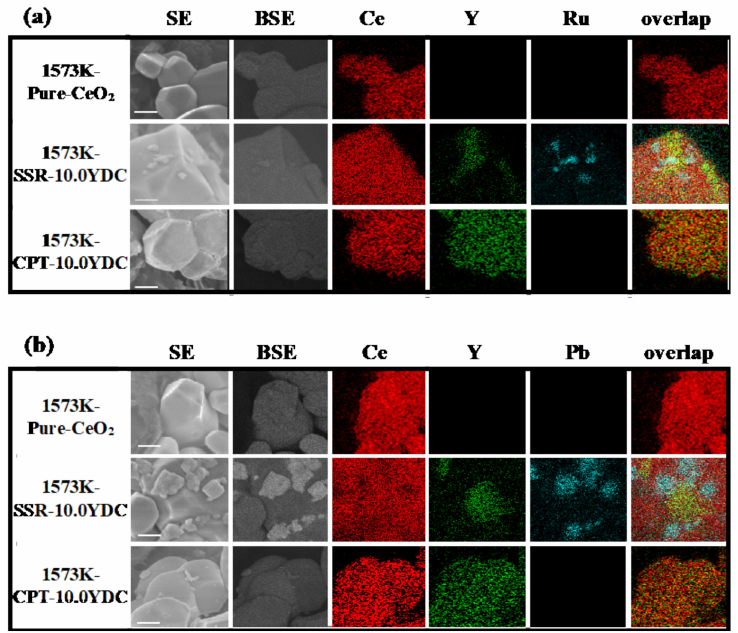
Figure 3. FE-SEM/EDS images of 1573K-Pure-CeO 2 , 1573K-SSR and 1573K-CPT. Ru ( a ) and PbO 2 ( b ) were photo-deposited on active site. Scale bars are 100